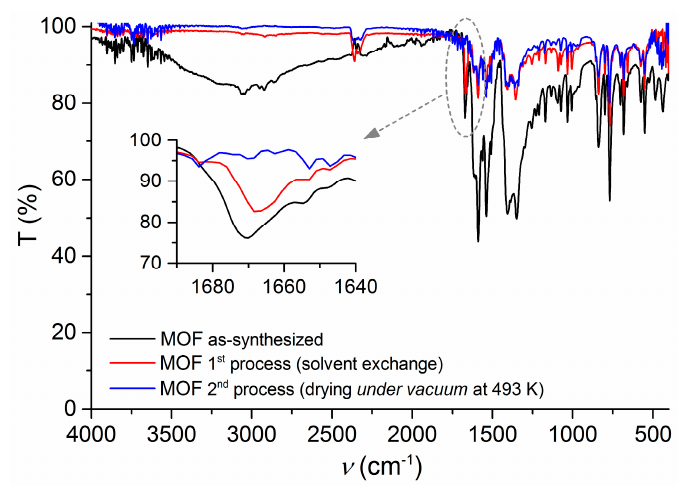
Figure 3. FTIR spectra of [Zn 2 (bpdc) 2 (bpee)] obtained from different conditions: as-synthesized ( black ), after the first process—solvent exchange ( red )—and after the second—drying under vacuum at 493 K for 5 h ( blue ).